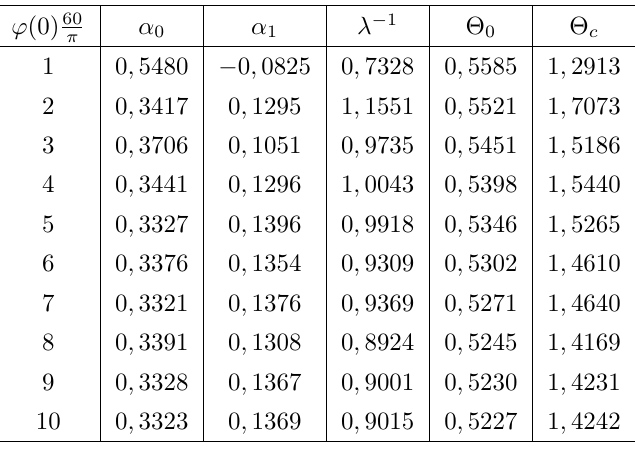
Table 5 . Length parameters for